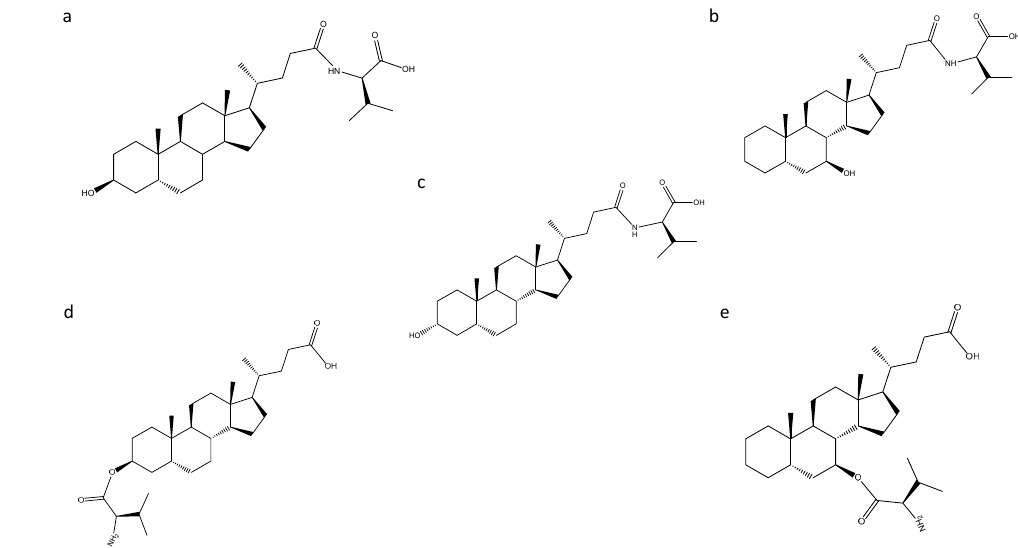
Figure 4. MCBAs of valine identified. ( a ) valoisolithocholic acid; ( b ) valoiso7 β -Hydroxy-5 β -cholan- 24-oic acid; ( c ) valolithocholic acid; ( d ) valoisolithocholate ester; ( e ) valoiso7 β -Hydroxy-5 β -cholate ester.